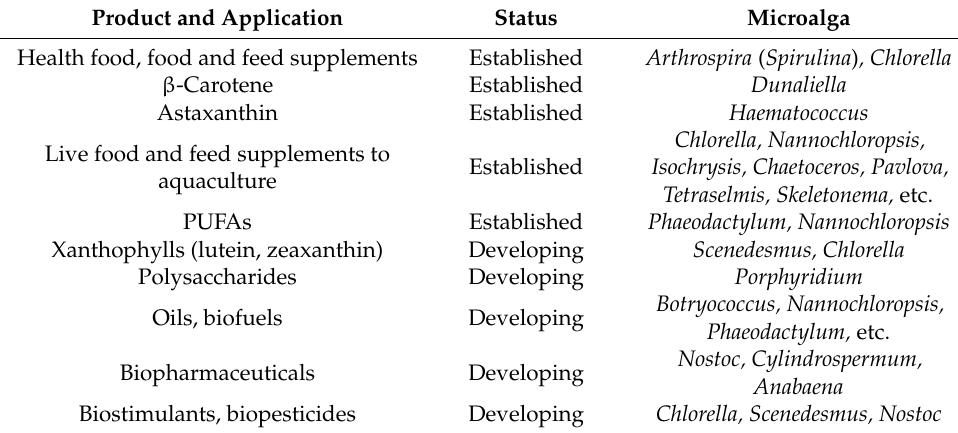
Table 2. The current industrial-scale biotechnology applications of the most exploited microalgae (modified from